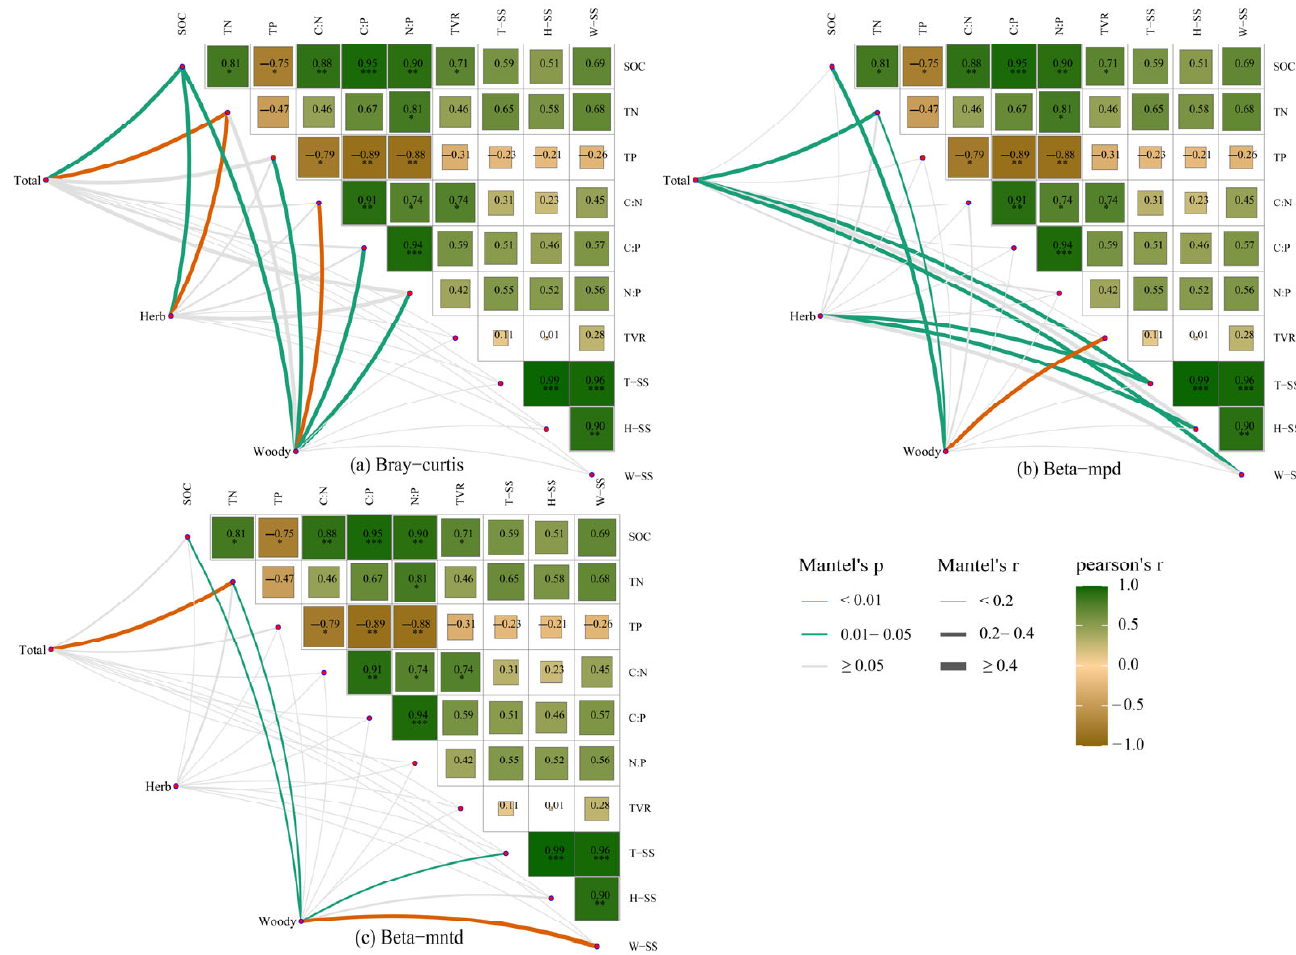
Figure 5. The Mantel test on the relationship between plant community β‐ diversity (( a ), the Bray ‐ Curtis dissimilarity index; ( b ), beta diversity index of the mean pairwise phylogenetic distance; ( c ), TVR, and SS. ***— p < 0.001; **— p < 0.01; *— p < 0.05. TVR indicates the time after vegetation resto ‐